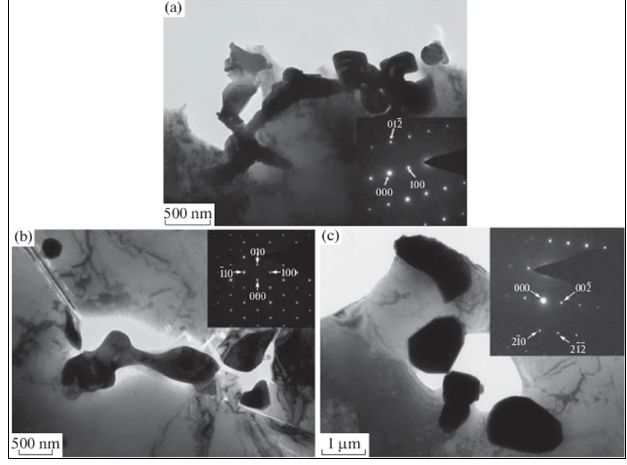
Figure 12. TEM bright field photographs, SAED patterns, and EDS element analysis results of speci- mens at different annealing temperatures. ( a ) 1000; ( b ) 1100; ( c ) 1200 ◦ C (adapted with permission from Ref. [39] 2021, Springer).